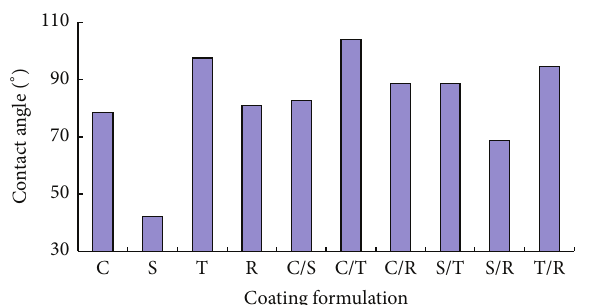
Figure 5: Effects of coating formulations on contact angles of the resulting coated papers, C: CaCO 3 ; S: SiO 2 ; T: talc; R: sericite, with mixing ratios of 50/50.